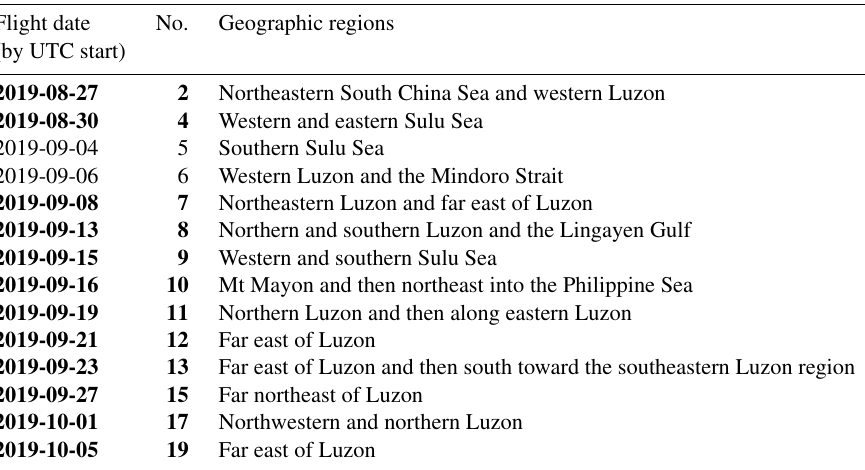
Table 1. CAMP 2 Ex P-3 research flights (RFs) with successful coordination between P-3 and MODIS. RFs in bold indicate successful overlap between RSP sampling and